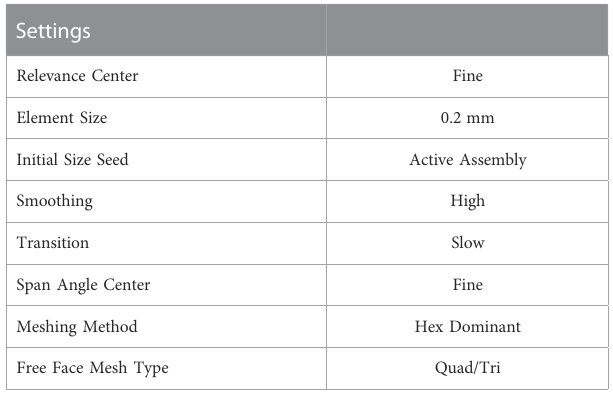
TABLE 3 Properties of PA-CF material. TABLE 4 Mesh settings for